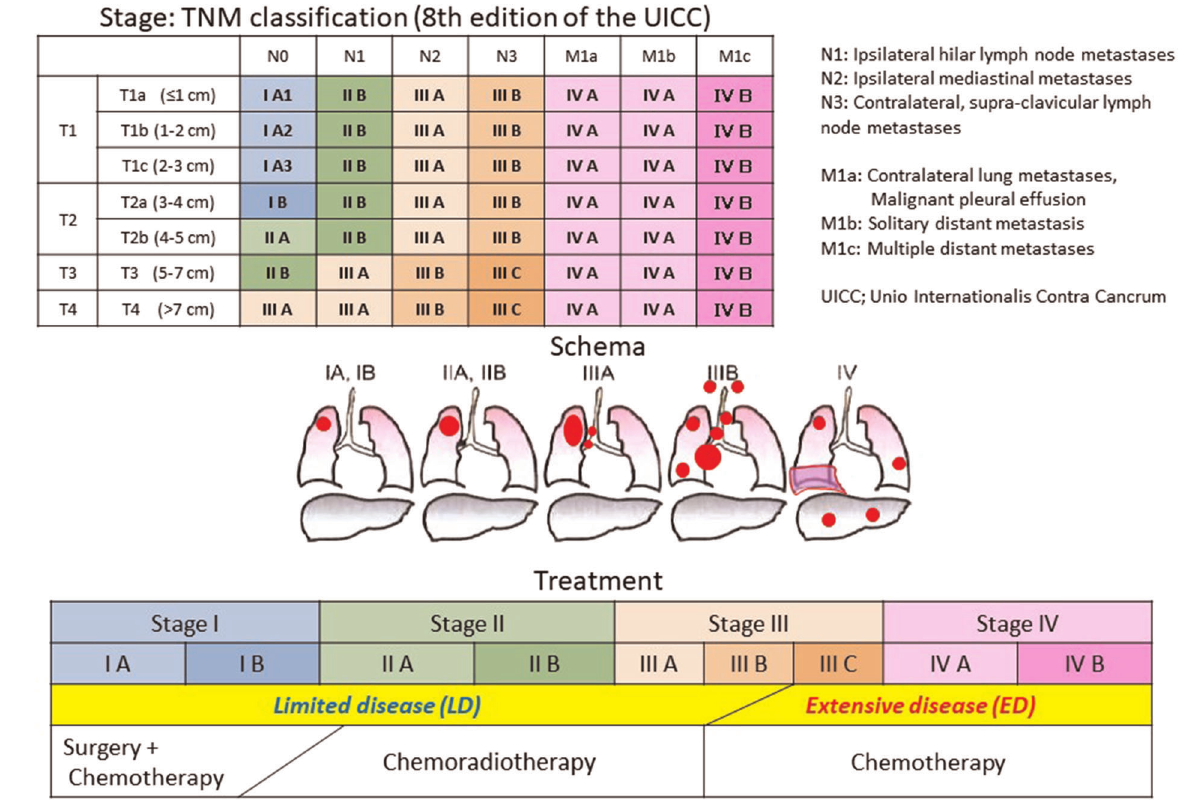
FIGURE 3 Stage and treatment of small-cell lung carcinoma. CRT is administered for the limited disease (LD), where the lesion is contained in a single area on one side of the chest for which radical irradiation is possible. Chemotherapy is used for the extensive disease (ED), where the lesion has spread beyond a single area and cannot be treated using radical